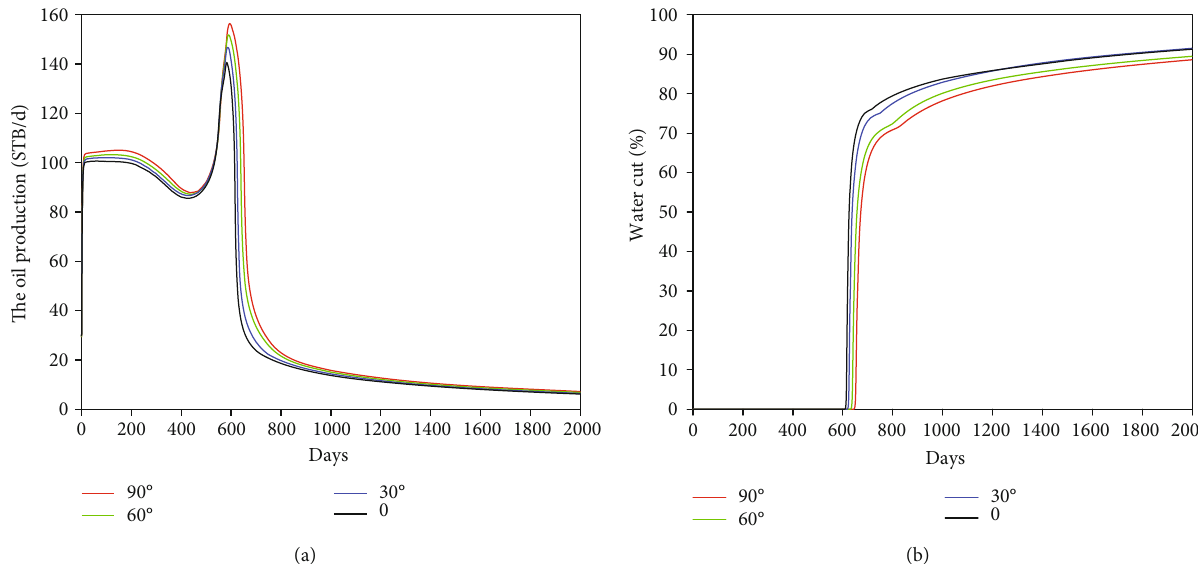
Figure 4: (a) Curve of oil production and water cut when permeability is 250md and interlayer angle is 0, 30, 60, and 90. (b) The water cut curve a ff ected by di ff erent interlayer angles under the same permeability.